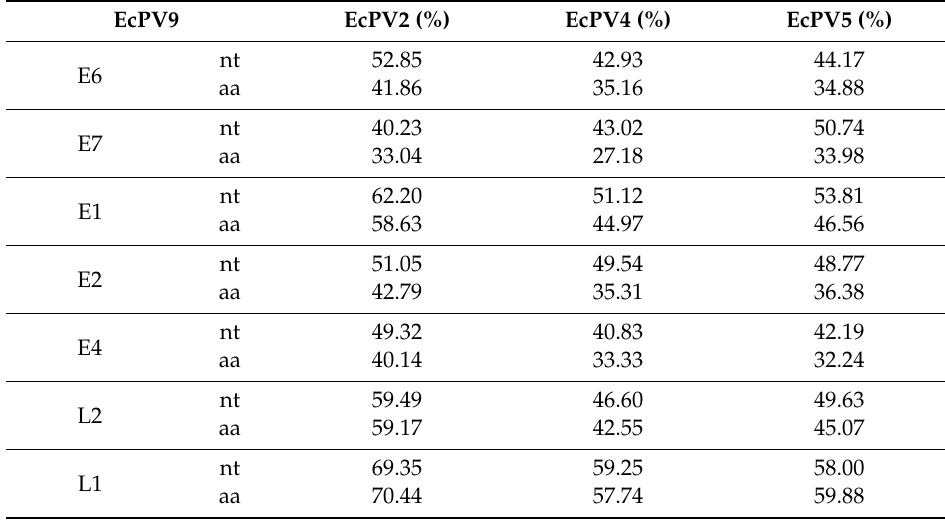
Table 1. Comparison of sequence similarity based on nucleotide and amino acid sequences of 7 ORFs with EcPV9 to EcPV2, EcPV4, and EcPV5.